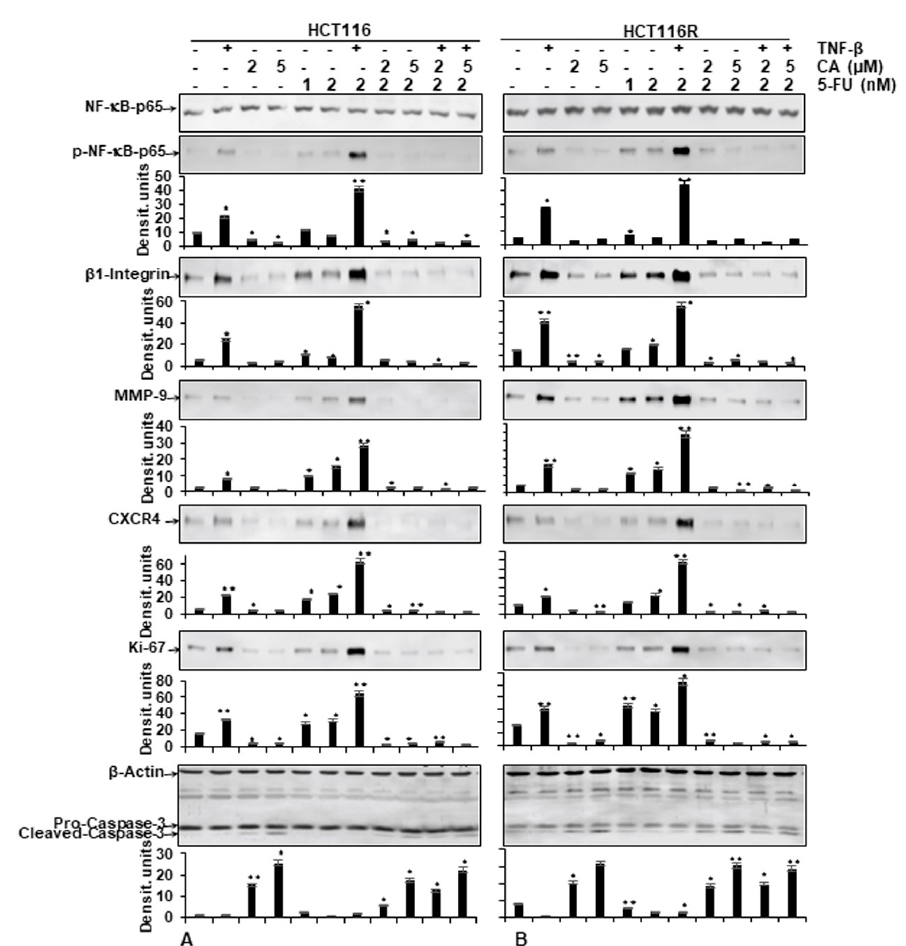
Figure 5. Effect of Calebin A and/or 5-FU on TNF-β-promoted p65-NF  B activation and NF -κ B - regulated gene end-products involved in apoptosis, proliferation and metastasis promoted by TNF - β in CRC cells Immunoblotting of whole-cell lysates from HCT116 ( A ) and HCT116R ( B ) in monolayer cultures treated as described in the Materials and Methods section was performed for anti-p65-NF-  B, anti-phospho-p65-NF-  B, anti-β1-integrin, anti-MMP-9, anti-CXCR4, anti-Ki67 and anti-cleaved-